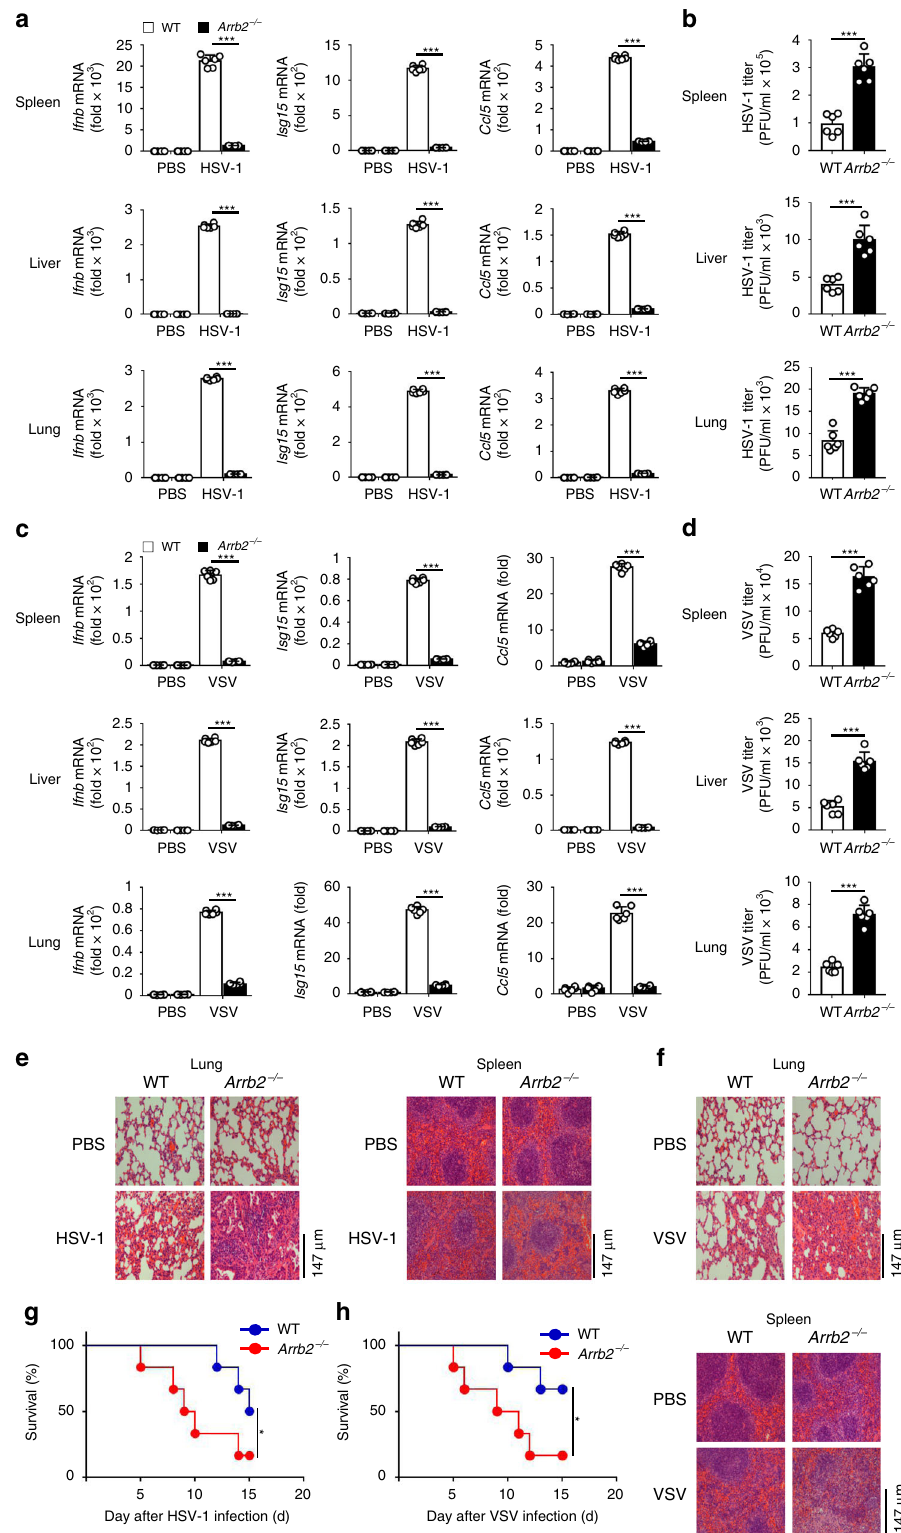
Fig. 3 De fi ciency of β -arrestin 2 diminished the antiviral immune response in vivo. a Ifnb , Isg15 , and Ccl5 mRNA levels in the spleens, livers, and lungs of WT and Arrb2 − / − 6-week-old male mice ( n = 6 per group) intraperitoneally injected with PBS or HSV-1 (2 × 10 7 PFU per mouse) for 48 h (*** P < 0.0001 in all panels). b The virus titers as in a (*** P < 0.0001 in all panels). c VSV (5 × 10 7 PFU per mouse) infection as in a (*** P < 0.0001 in all panels). d The virus titers as in c (*** P < 0.0001 in all panels). e , f Microscopy of hematoxylin- and eosin-stained lung and spleen sections as in a or c . g , h Survival of WT and Arrb2 − / − 6-week-old male mice ( n = 6 per group) infected intraperitoneally with a high dose of HSV-1 (2 × 10 8 PFU per mouse) g (* P = 0.0430) or VSV (5 × 10 8 PFU per mouse) h (* P = 0.0411) and monitored for 15 days. Data are representative of at least three independent experiments (mean ± SEM, two- tailed unpaired Student ’ s t -test in a – d or Kaplan – Meier analysis in g , h